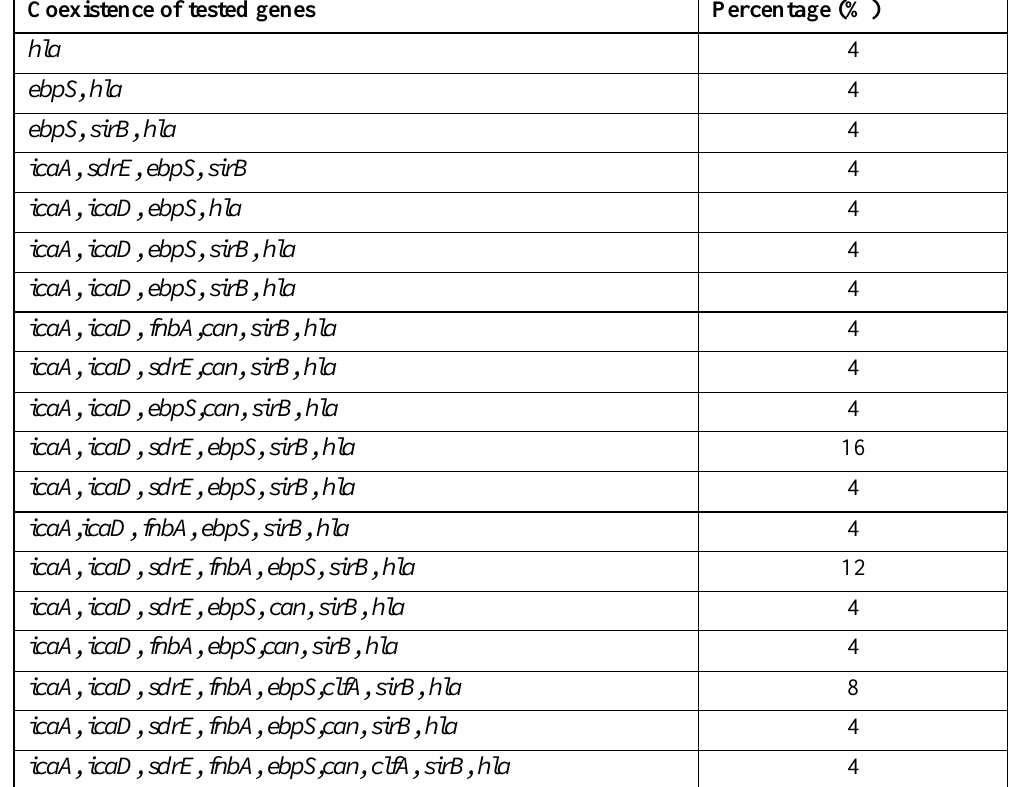
Table 2. Percentage of coexistence of genes under test among tested isolates. Coexistence of tested genes Percentage (%) hla 4 ebpS, hla 4 ebpS, sirB, hla 4